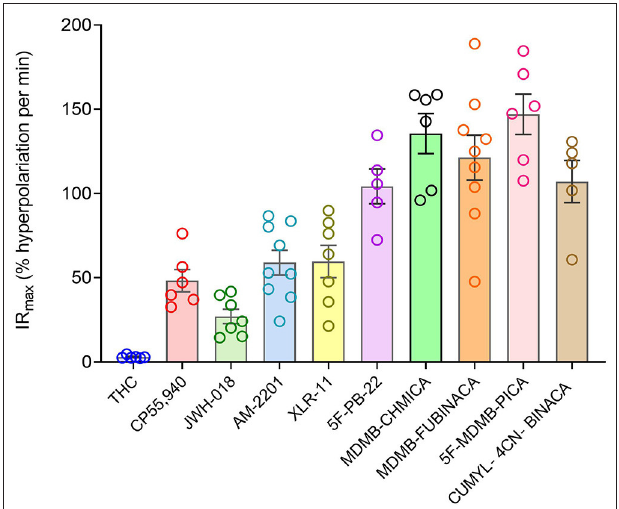
FIGURE 6 | Signal generation rate IR max values of CB 1 receptor agonists. The IR max was calculated as the initial rate of membrane potential reduction at a maximally-stimulating concentration of the agonists (10 µ M), as described in Materials and Methods. Note the signal generation rate of SRCAs and the synthetic agonist CP 55,940 is much higher than that of the natural cannabinoid THC. IR max values and statistical analysis are in Table 2 .